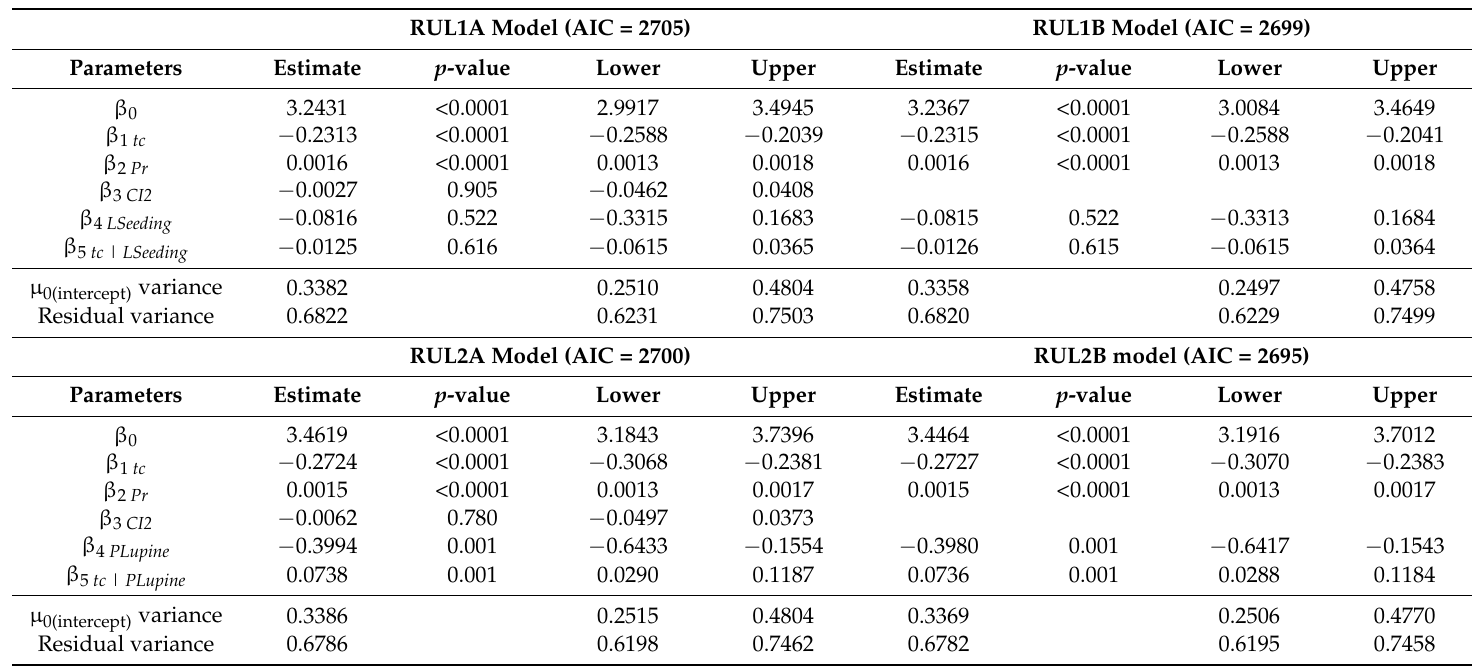
Table 3. Parameter estimates for the two alternative cork ring width (rw) models (with and without the CI variable) regarding the RUL management variables listed in Table 1 ( n = 1008), where: tc is the cork ring age (years); Pr is the annual precipitation (mm); CI2 is the number of competitors, within 20 m, with duj > dui; LSeeding takes value 1 in the year after lupine application (Autumn); PLupine takes value 1 in the two years following its